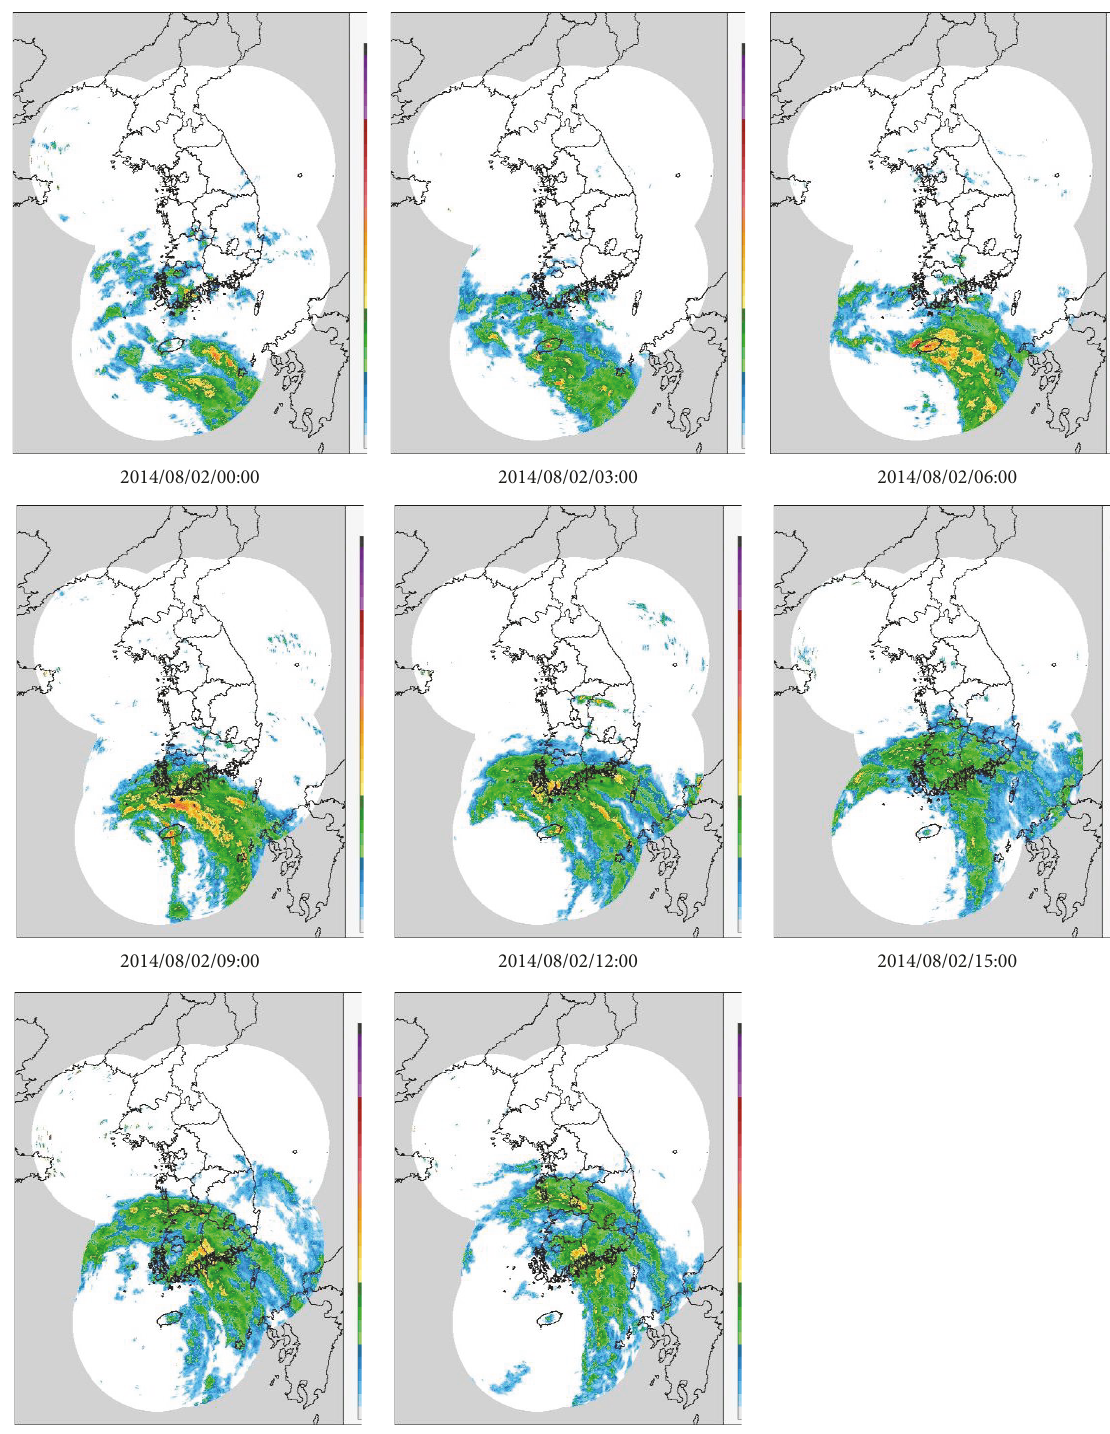
Figure 2: Synthetic radar image around the Korean Peninsula during the Typhoon Nakri in